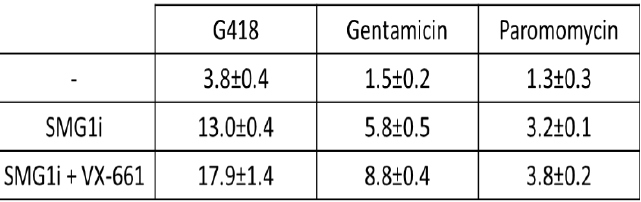
Figure 7. Folding of readthrough-facilitated CFTR can be improved with VX-661. ( A ). Representative brightfield images of G542X intestinal organoids treated with 100 µM G418, 2.5 mM gentamicin, or 2.5 mM paromomycin and indicated combinations of 1 µM SMG1i and/or 3.3 µM VX-661 at 0 min and 180 min following treatment with 10 µM forskolin. Scale bar is 100 µm. ( B ). Example FIS curves of G542X intestinal organoids treated with indicated doses. n = 3 wells per treatment group. ( C ). AUC measurements from intestinal organoids treated with the indicated doses of compounds as in 6A. * p < 0.0001 between indicated treatment groups, ^ p < 0.0001 from DMSO by one-way ANOVA with post-hoc Tukey test. ( D ). Estimated percent of wild-type CFTR function comparing the initial rate of FIS of each group to wild-type ± SD. G542X organoids with no NMD, readthrough or corrector agents had an estimated 1.3 ± 0.7% of wild-type CFTR function. The initial rate was calculated from the linear phase of FIS swelling which was 10 minutes for wild-type and 45 min for G542X.